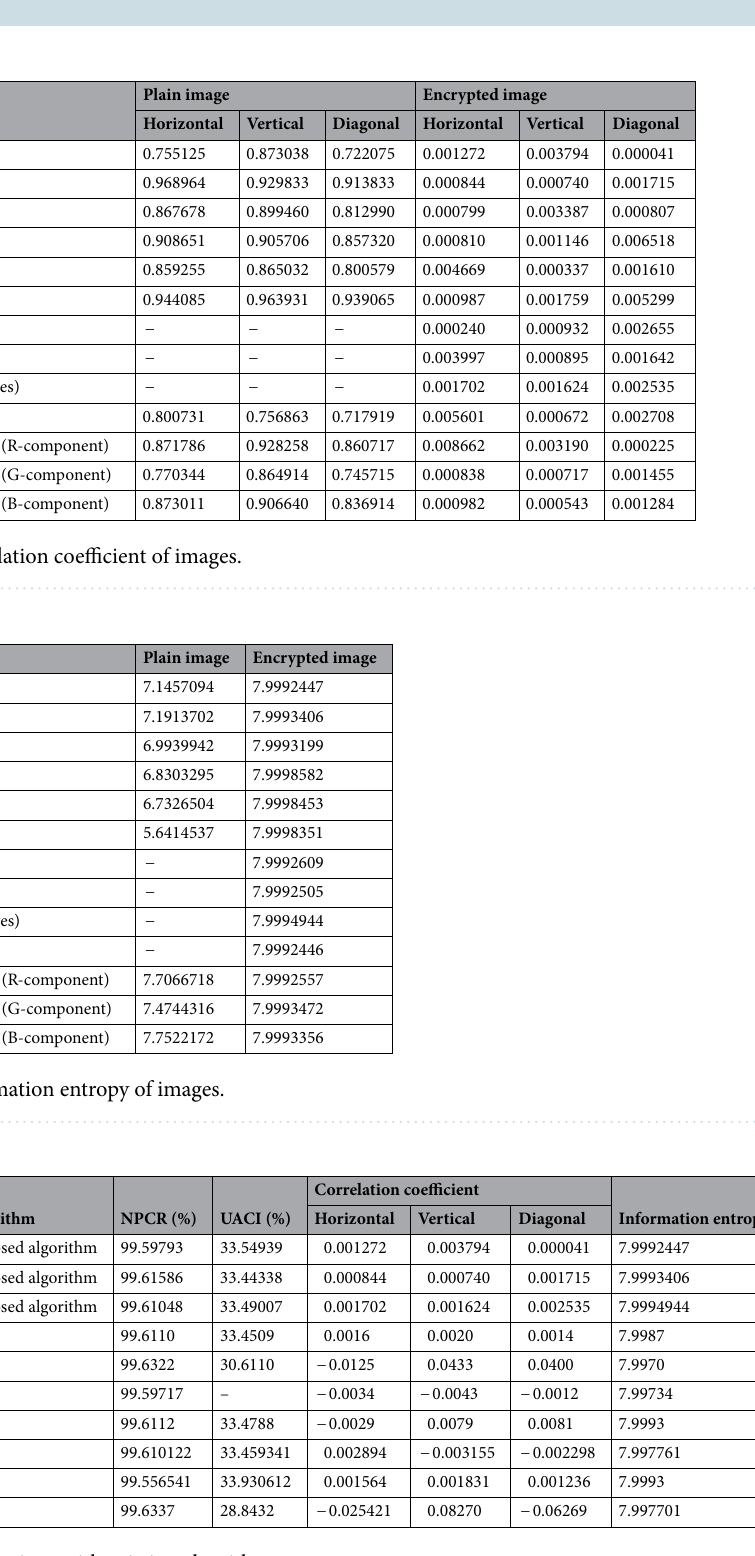
Table 5. Comparison with existing